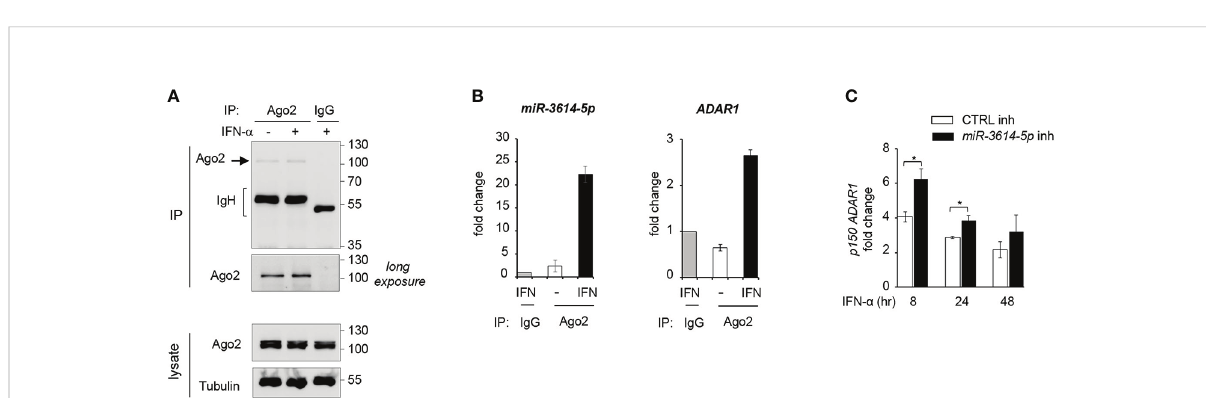
FIGURE 6 Endogenous miR-3614-5p is associated with Ago-2 and targets ADAR1 in IFN-stimulated cells. (A) HeLa cells were stimulated with IFN- a (100pM) for 24 hr and processed for Argonaute2-miRNA-co-immunoprecipitation. Endogenous Argonaute2 (Ago2) was immunoprecipitated (IP) from whole cell lysates with anti-Ago2 or an IgG control. Samples were analysed by western blot as indicated. (B) miR-3614-5p (left panel) or ADAR1 mRNA (right panel) was measured by qPCR in the Ago2 immunoprecipitated fraction relative to the IgG fraction, shown in A). The Ct values of miR3614-5p or ADAR1 in the IgG immunoprecipitate were substracted from the Ct values in Ago2 immunoprecipitates (IFN-treated or untreated) to generate D Cts. The results shown are expressed as fold change and represent the expression (2 - D Ct ) relative to control IgG set at 1. Data are mean +/- SEM of two independent experiments. (C) HeLa cells were transfected with the miR-3614-5p inhibitor ( miR-3614-5p inh) or the control inhibitor (CTRL inh). Two days later, IFN- a (100pM) was added. Relative expression of p150 ADAR1 was measured at different times after stimulation as indicated. The fold change represents the ratio of IFN-treated cells relative to non-treated cells. Values are means ± SEM (n=3 separate experiments). *p <